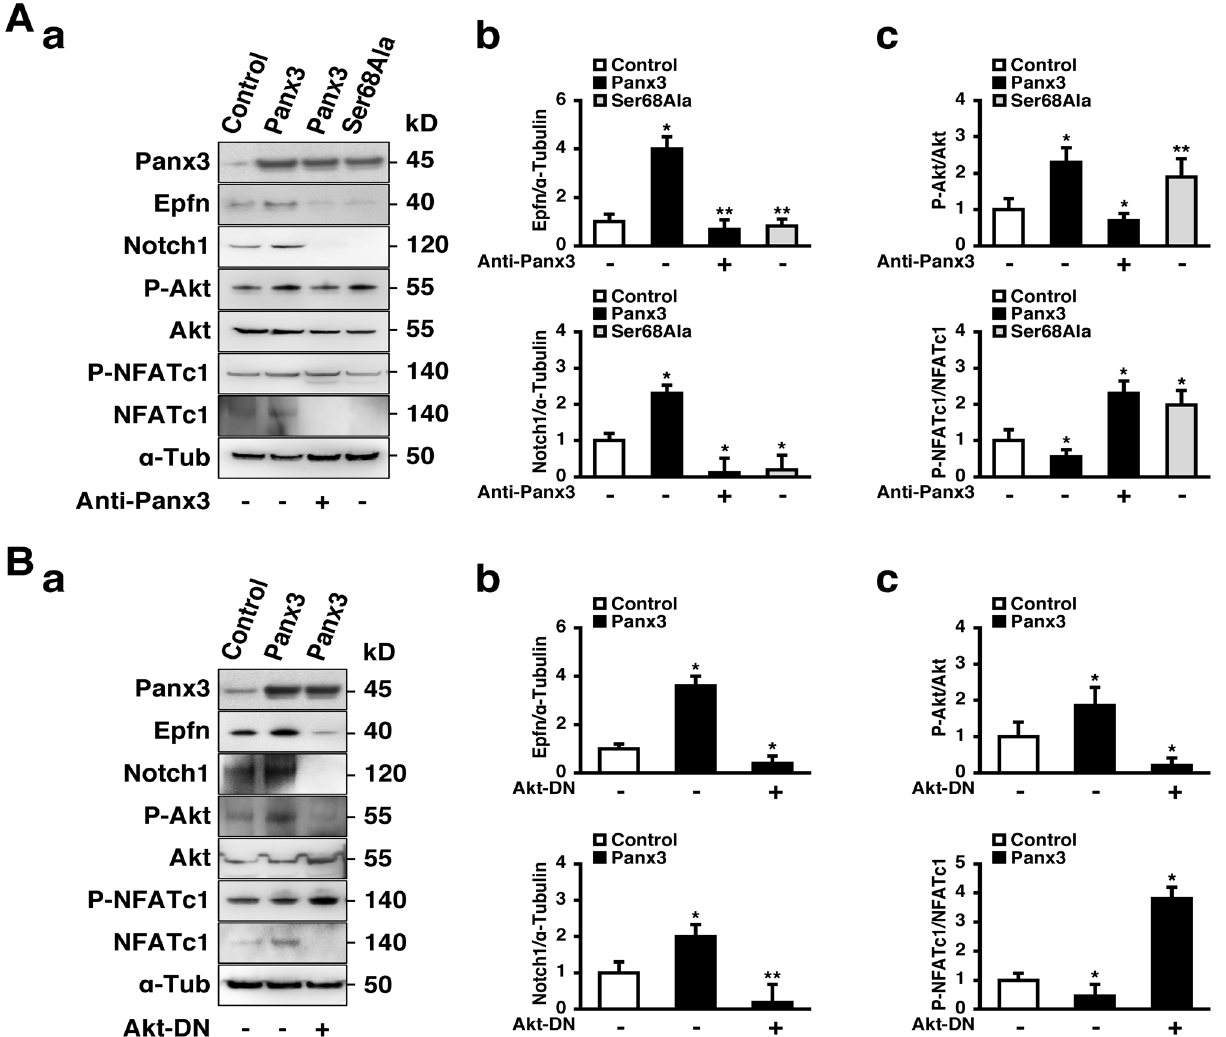
Figure 7. Panx3 ER Ca 2+ channel regulates Epfn via Akt/NFAT signaling pathway. HaCaT cells were cultured for 3 days in normal media. Western blotting was performed with antibodies to Panx3, Epfn, Notch1, phospho- Akt (P-Akt), Akt, phospho-NFATc1 (P-NFATc1), NFATc1, and α-Tubulin. The cropped blots were used in the figures. Full blot is shown in the Supplementary Information (Full Original Blots-I–IV). ( B ) Quantification of the ratios of Epfn/α-Tubulin (upper panel of A , b and B , b ) and Notch1/α-Tubulin (lower panel of A , b and B , b ), P-Akt/Akt (upper panel of A , c and B , c ) and P-NFATc1/NFATc1 (lower panel of A , c and b, c ). ** p < 0.05, * p < 0.01. Error bars represent the mean ± SD; N =